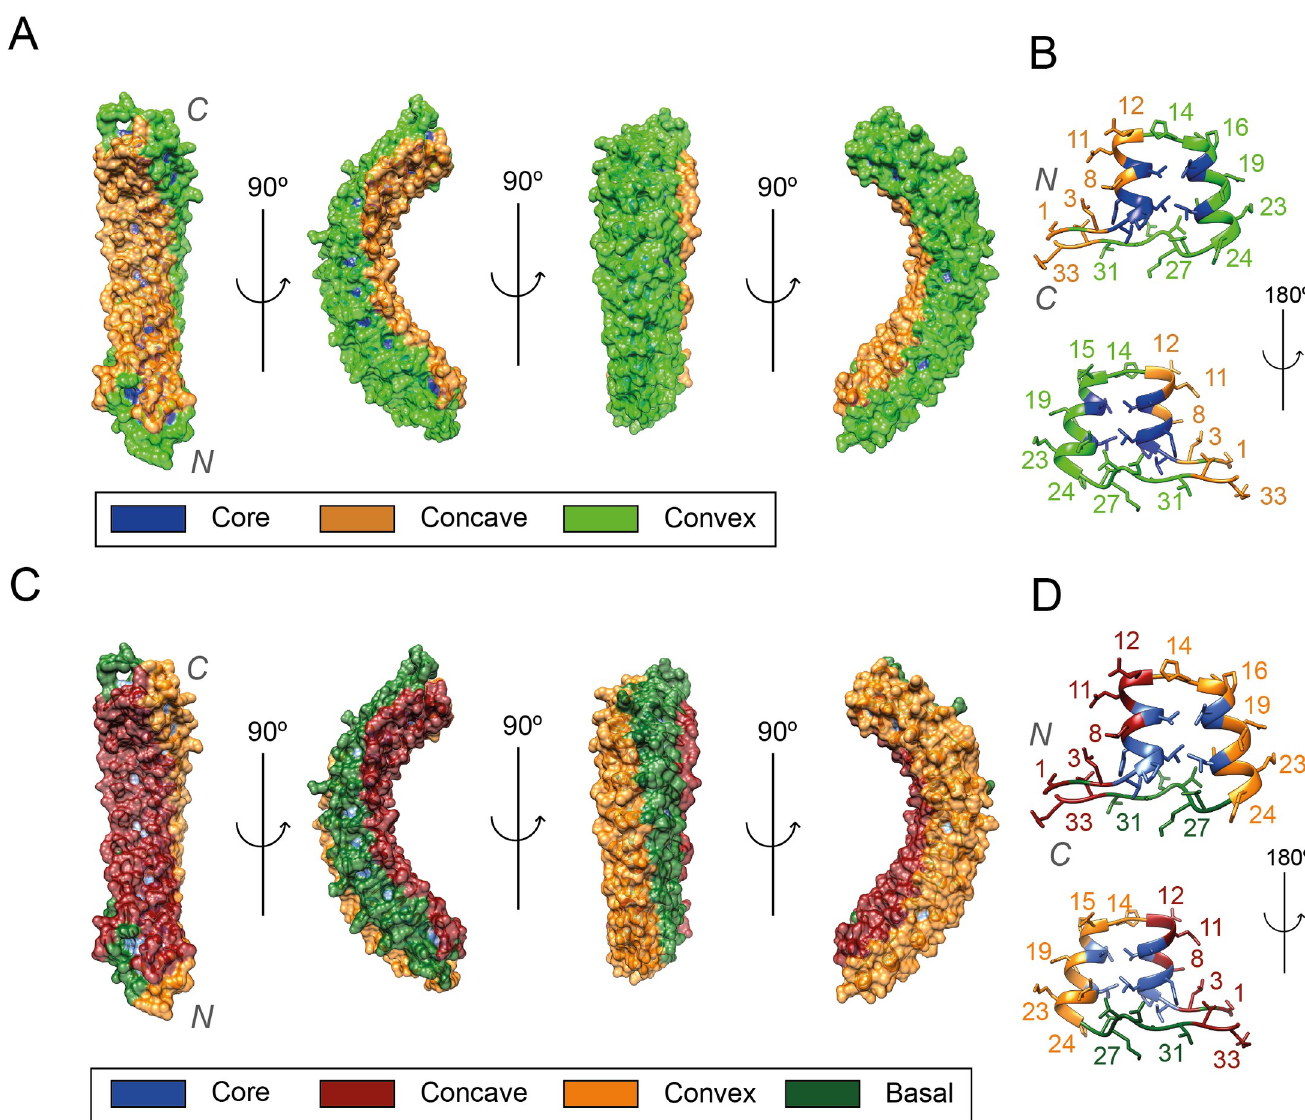
Fig 8. Comparison of the original definition of the ARD surfaces (A, B) with the new definitions derived from the results of this study (C, D). All panels refer to the D34 region of ANK1 ARD, PDB accession: 1N11 [53]. This structure shows 12 out of the 23 ARs found on this ARD; (A) Surface of an ARD. Residues conforming the concave surface are coloured in orange, residues on the convex surface in green and buried residues in blue; (B) Structure of an individual repeat. The first α - helix and the β -turn region form the concave surface, whereas the second helix and the loop form the convex one; (C) Residues forming the concave surface are coloured in dark red, residues on the convex surface in orange, the basal surface is coloured on dark green and buried residues in blue; (D) Structure of an individual repeat with new surface classification. Figure obtained with UCSF Chimera [7].